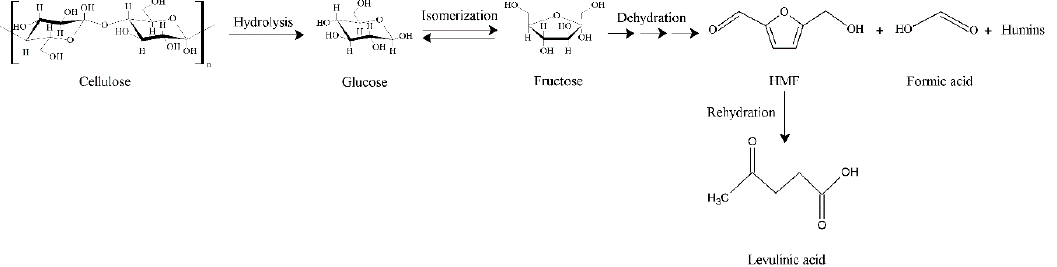
Figure 1. The mechanism of cellulose hydrolysis to levulinic acid (LA).